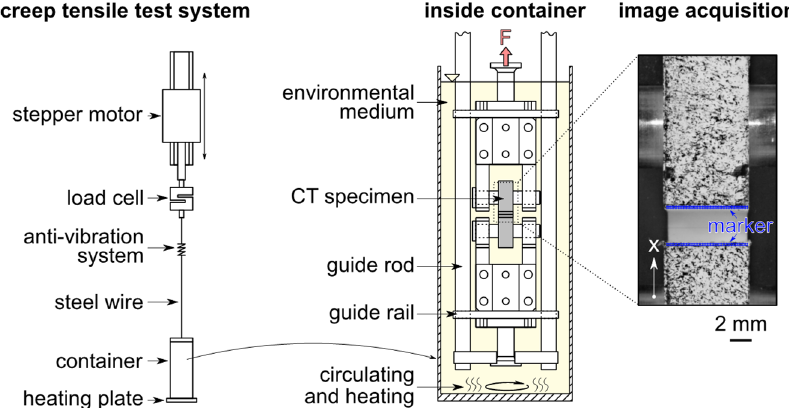
Figure 3. Clamping of a CT sample for static loading in a temperature-controlled environmental medium of the electronically controlled tensile creep system. Uniaxial displacement in load direction by specimen grips using guide rails along the guide rod. Image acquired with a digital camera during the experiment for optical COD(t) measurement.